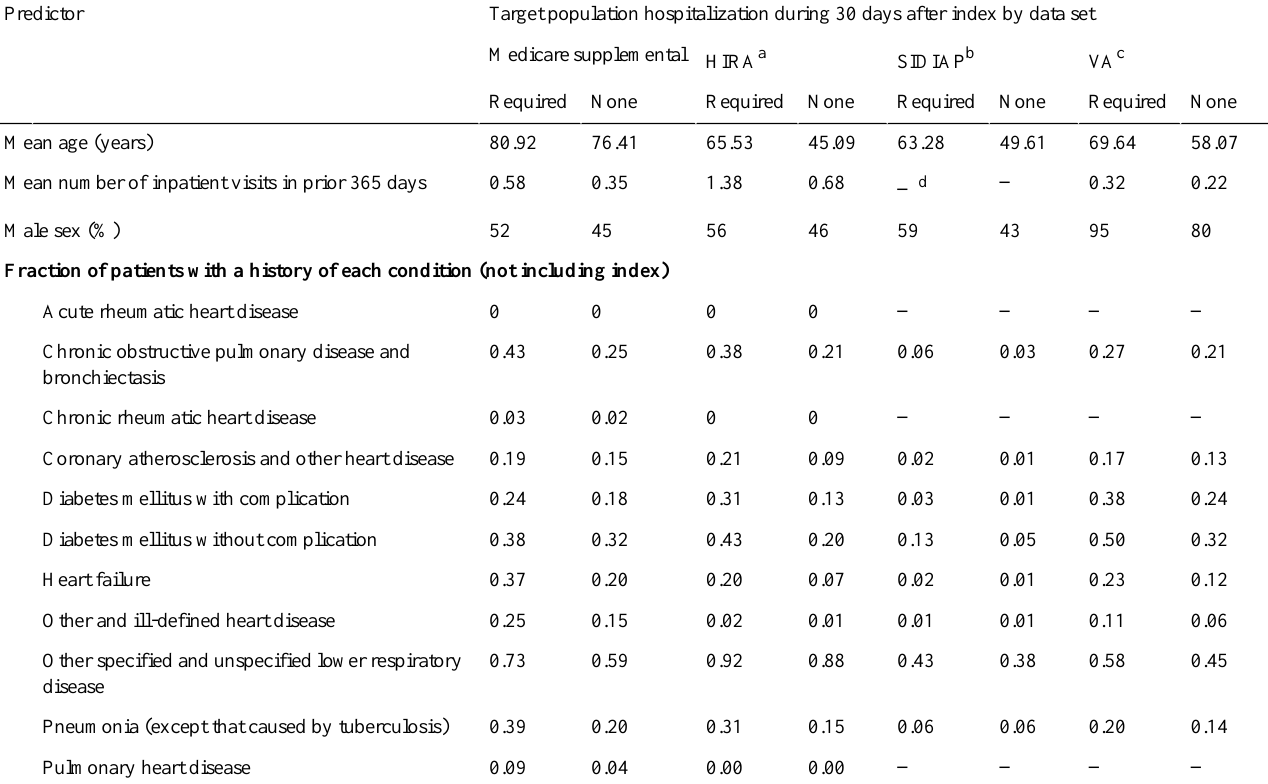
Table 1. Characteristics of patients at baseline in MDCR (database similar to the development data) and the data sets with COVID-19 data. Target population hospitalization during 30 days after index by data